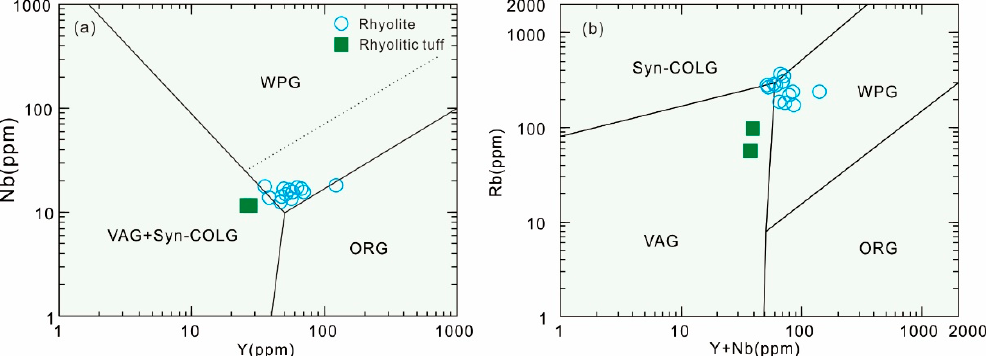
Figure 9. Tectonic discrimination diagrams for the Early Devonian volcanic rocks in the Haerdaban area. ( a ) Nb versus Y and ( b ) Rb versus Y + Nb (reference area after [76,77]). Syn-COLG: syn-collision granites; WPG: within plate granites; VAG: volcanic arc granites; and ORG: ocean ridge granites.